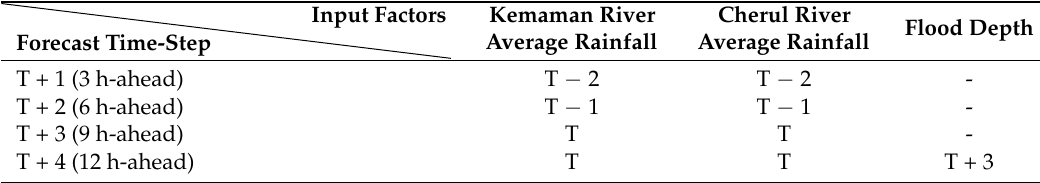
Table 3. Input combinations for the RNARX